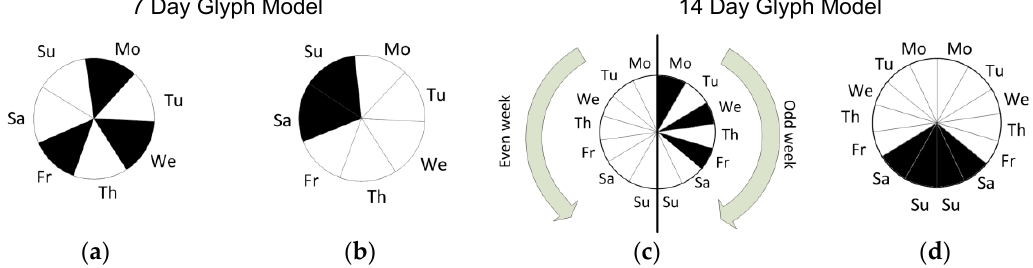
Figure 4. WeekCircle glyph represented in two modes: ( a ) and ( b ) glyphs are depicted in 7-day mode and ( c ) and ( d ) glyphs are depicted in 14-day mode.